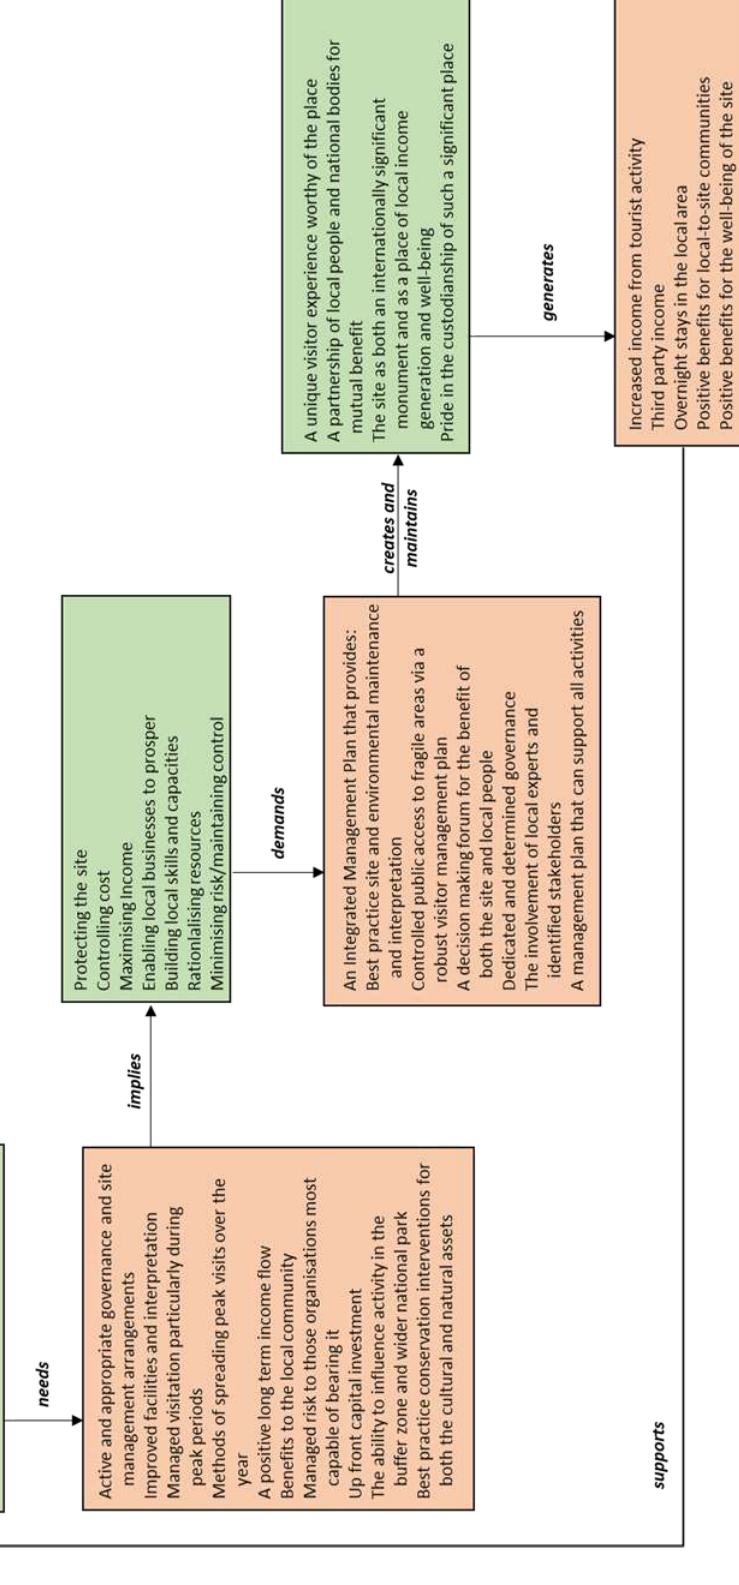
Figure 22: Issues analysis for a sustainable